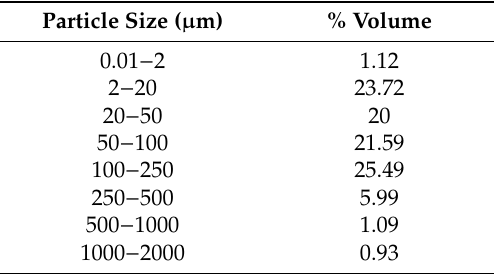
Table 4. Division of the fly ash into